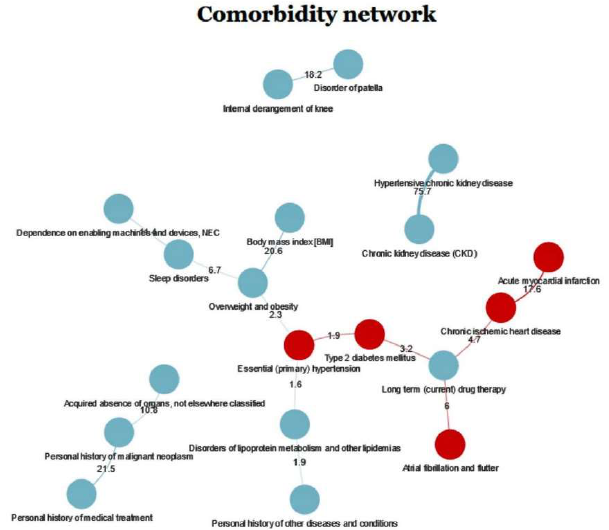
Figure 1. Comorbidity network for new male users of lipid-lowering drugs. Nodes represent diagnoses (in red: cardiovascular diseases or cardiovascular risk factors). Lines are the relationship between diagnoses. The magnitude between diagnoses indicates the number of times that two diagnoses co-occur in the sample, after discarding all pairs of diagnoses that only appear